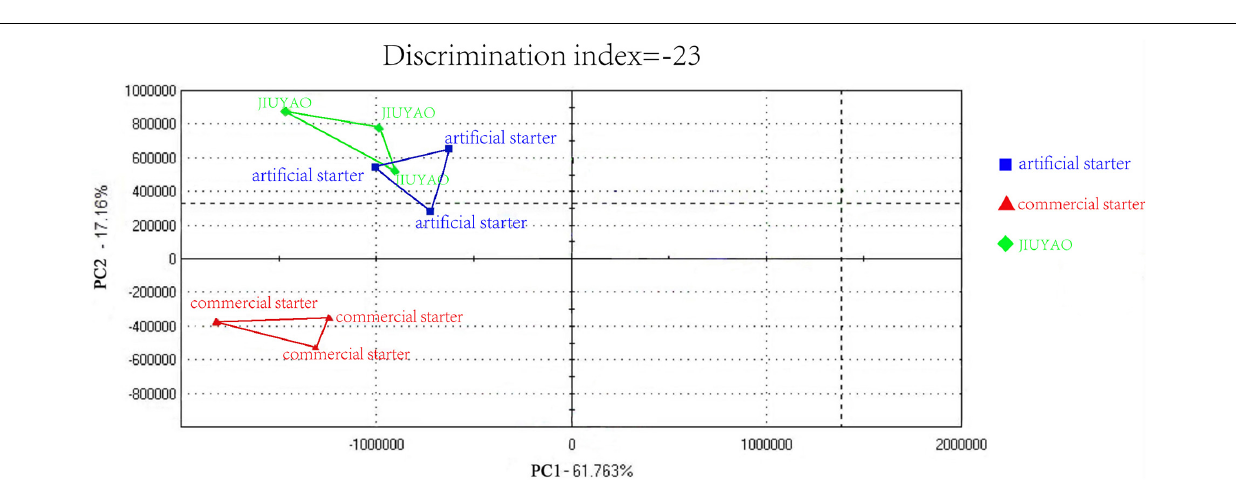
using response surface methodology. The regression equations of the models were evaluated using the F -test for the analysis of variance. A principal component analysis was performed using WinMuster version 1.6.2 (Alpha M.O.S., Toulouse,